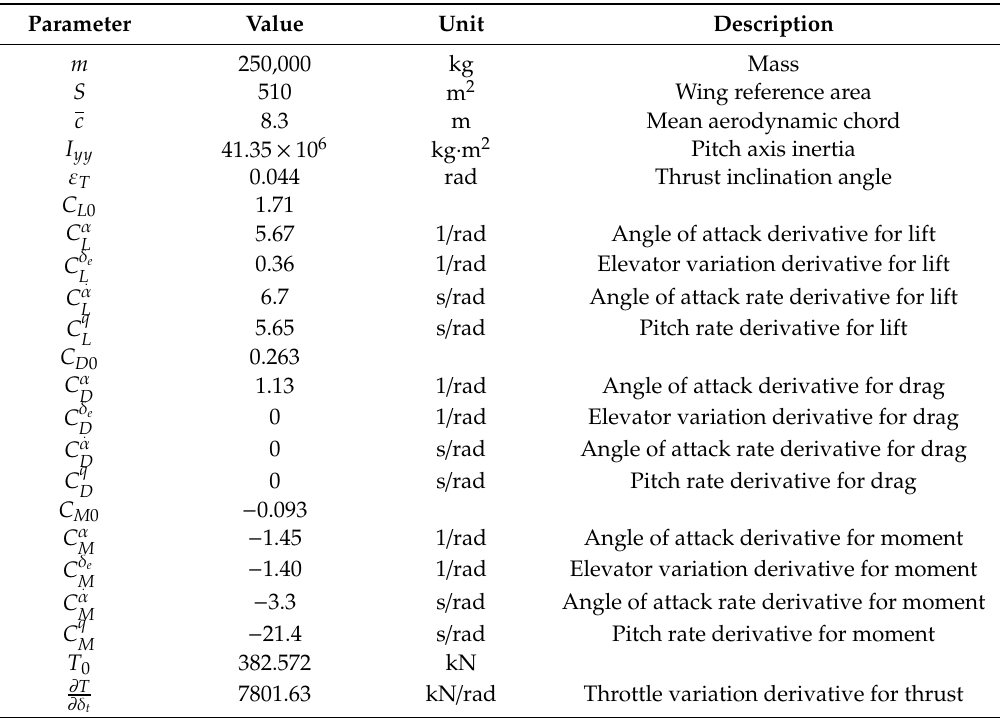
Table 1. The Boeing 747 aircraft parameters.